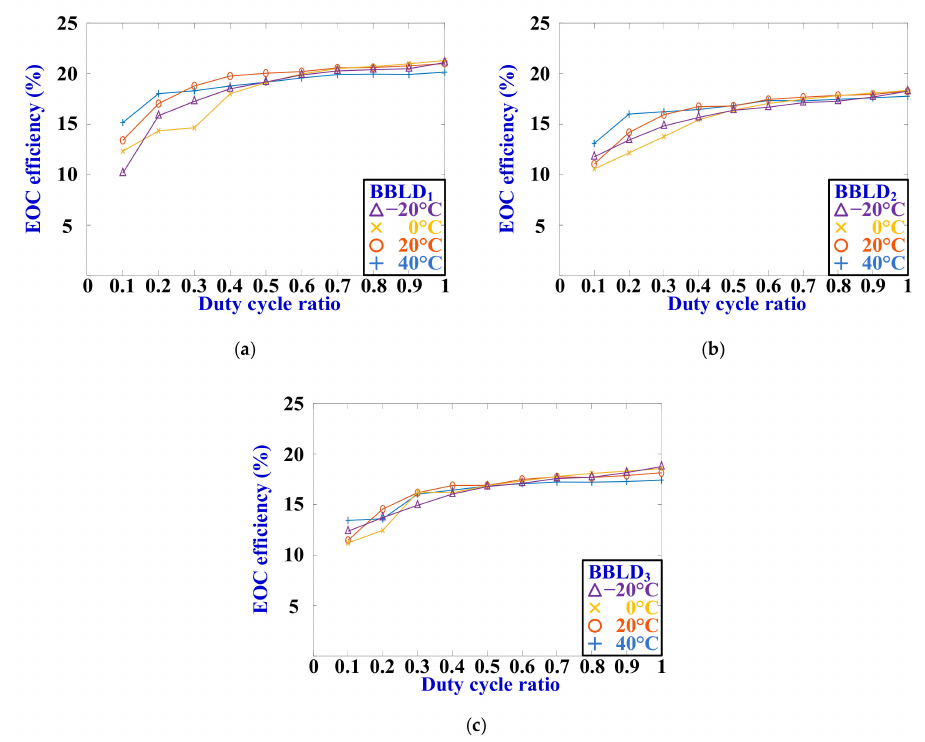
Figure 21. EOC e ffi ciency using electrical power RMS value calculation ( f s = 100 Hz). ( a ) BBLD 1 .